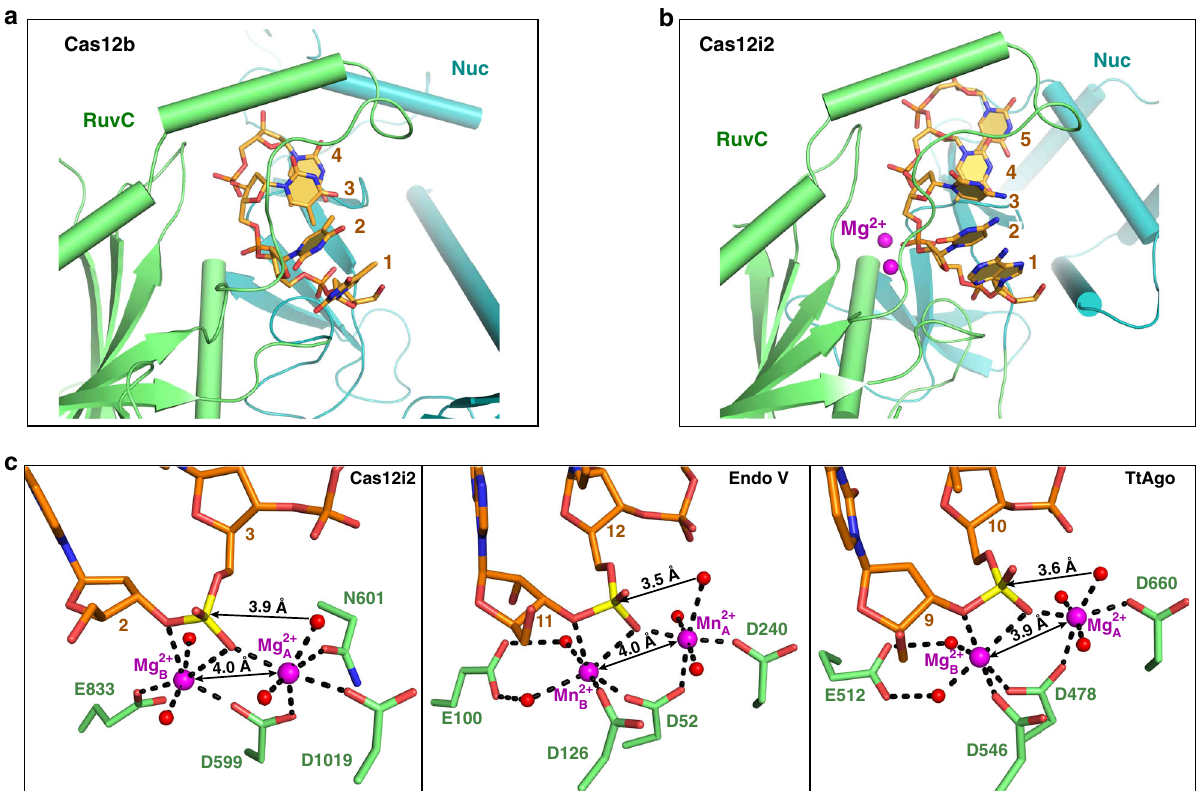
Fig. 7 Structural comparison of Cas12i2, Cas12b, and other RNase H fold-containing proteins. a , b Comparison of the ssDNA substrate and the RuvC domain in AacCas12b ( a ) and Cas12i2 ( b ). c The substrate and two metal cations in the catalytic pocket of Cas12i2 (left panel), mouse Endonuclease V (center panel, PDB ID: 6OZL), and TtAgo (right panel, PDB ID: